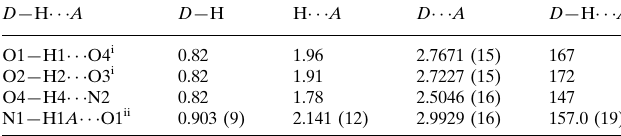
Hydrogen-bond geometry (A˚ , (cid:1)